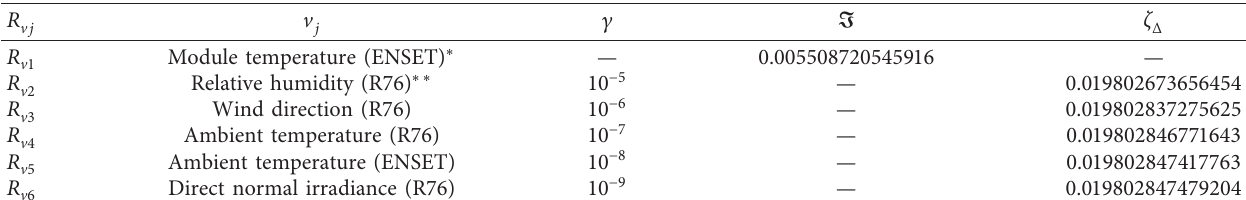
for 2kWp PV power station. Δ